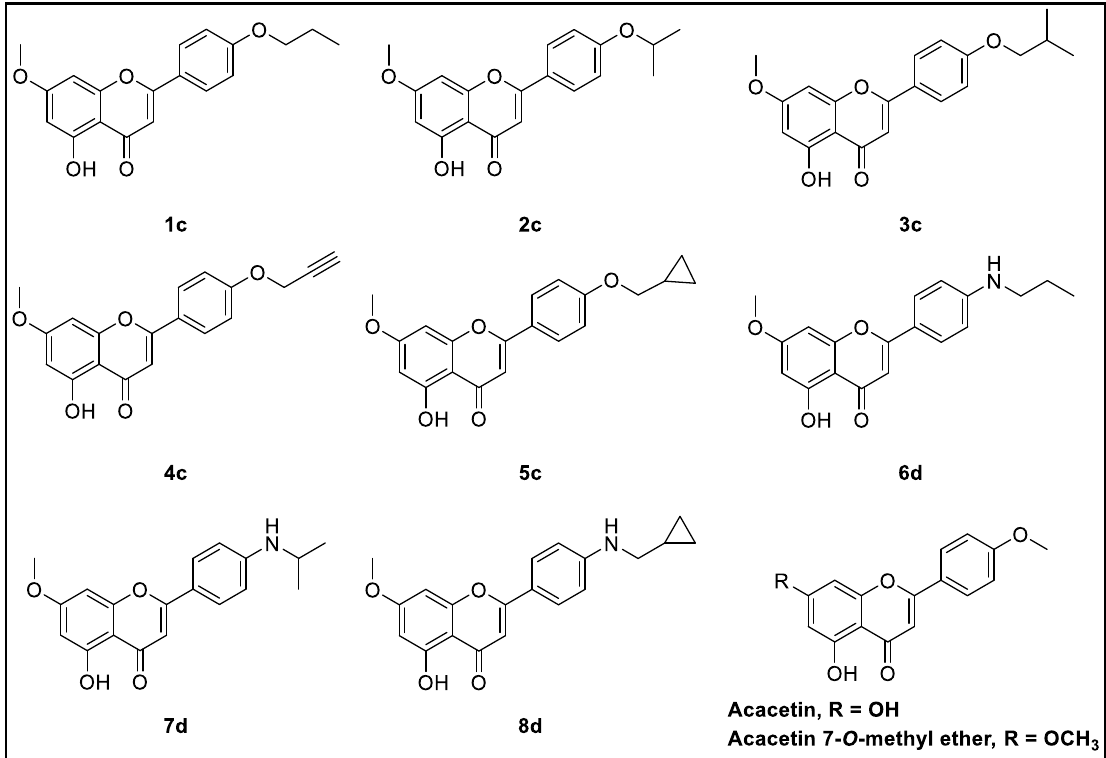
Figure 5. Water map of the MAO-B active site ( A ) and fitting of pose 1 ( B ) and pose 2 ( C ) with site hydration properties. Favorable regions for water molecules and polar groups are shown as yellow surfaces; hydrophobic regions are shown in purple.